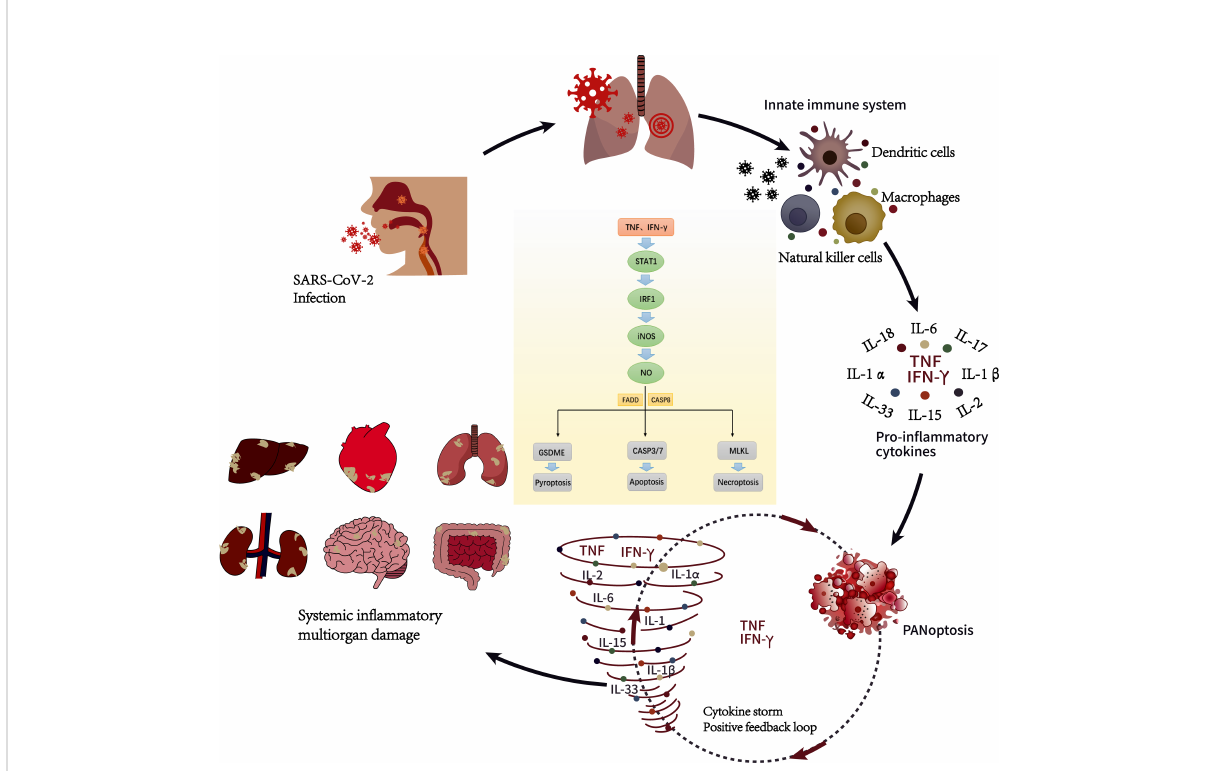
FIGURE 1 Cytokine storm during SARS-CoV-2 infection (Diamond and Kanneganti, 2022). SARS-CoV-2 enters the host through the respiratory tract. After entering the cells, they will replicate and invade the adjacent cells and extracellular space, of which respiratory symptoms are the most common. After the innate immune system is activated, innate immune cells such as dendritic cells, macrophages and natural killer cells react and release pro-in fl ammatory cytokines such as TNF and IFN- g to control infection. When the release of proin fl ammatory cytokines is unbalanced, it will cause in fl ammatory cell death characterized by pyroptosis, apoptosis, and necroptosis (PANoptosis). It is characterized by a sharp increase in cytokines and a positive feedback loop in the pathway of programmed cell death related to in fl ammation, which we call cytokine storm, which can eventually develop into multiple organ dysfunction. Under the joint action of TNF and IFN- g , it can activate JAK-STAT1-IRF1 axis, induce nitric oxide production and drive caspase8/FADD- mediated